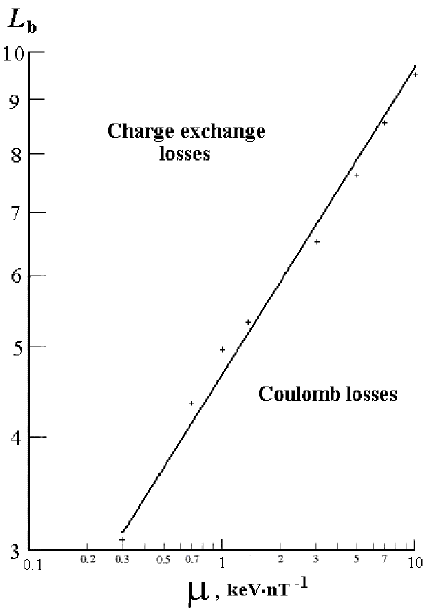
Figure 9. The dependence from µ of the boundary L b where the rate of Coulomb losses is equal to the rate of the charge exchange of protons. This dependence is obtained from Fig. 8 (results of Fig. 8 shows the crosses). Thick line shows the power approximation of this dependence (Eq.